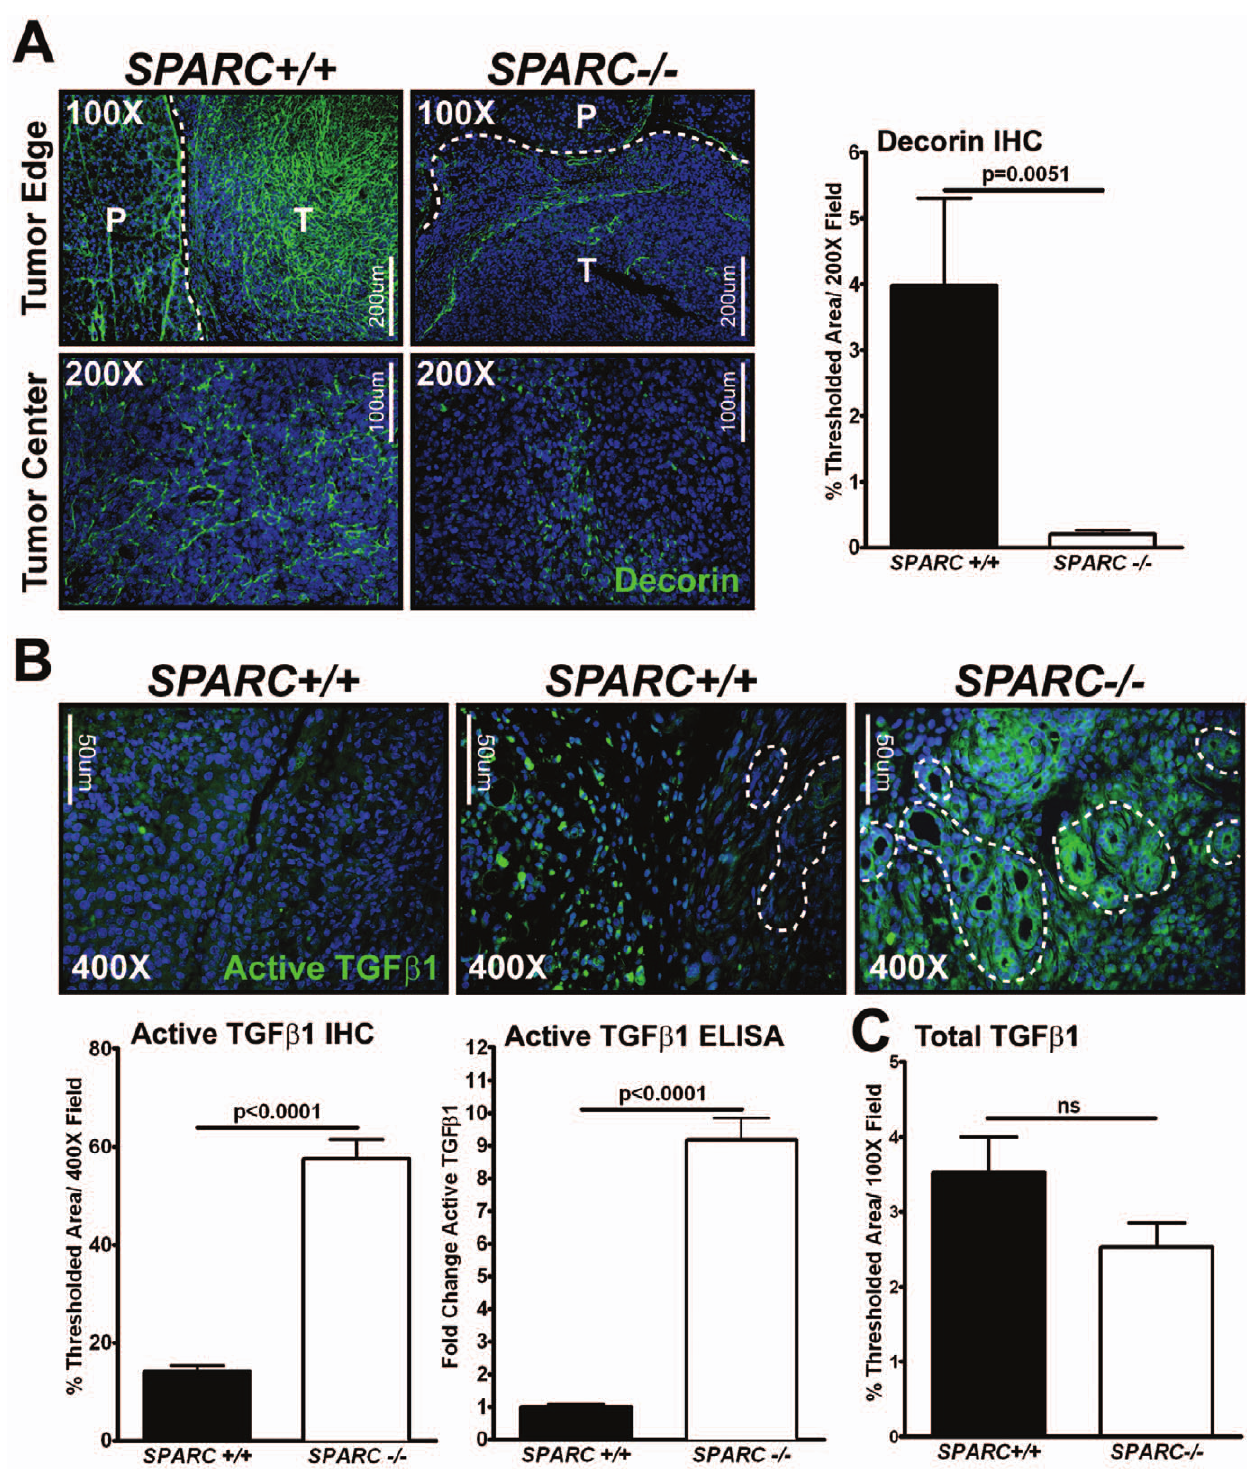
Figure 1. TGF b 1 and the TGF b binding proteoglycan, decorin, are altered in tumors grown in the absence of stromal SPARC. Fluorescence immunohistochemistry was utilized to quantify the amount of active and total TGF b 1, as well as decorin in tumors grown in SPARC + / + and SPARC 2 / 2 mice (A–C). (A) Tumor sections were stained with antibody goat anti-decorin (green) and percent thresholded area quantified. DAPI (blue) marks cell nuclei. Images were taken at the tumor edge (top panels) and the tumor center (bottom panels). Total magnification is 100 6 (scale bar, 200 m M) and 200 6 (scale bar, 100 m M) as indicated. Dotted lines indicate the border between the tumor (T) and normal pancreas (P). (B) Tumor sections were stained with an antibody rabbit anti-TGFaˆ1 (green) specific for the active form and percent thresholded area quantified. DAPI (blue) marks cell nuclei. Total magnification is 400 6 (scale bar, 50 m M) as indicated. Dotted lines indicate spontaneous abnormal ducts arising from the Pan02 cells within the tumor. The amount of active TGFaˆ1 in tumor lysates was also measured using a commercial sandwich ELISA kit (G7591